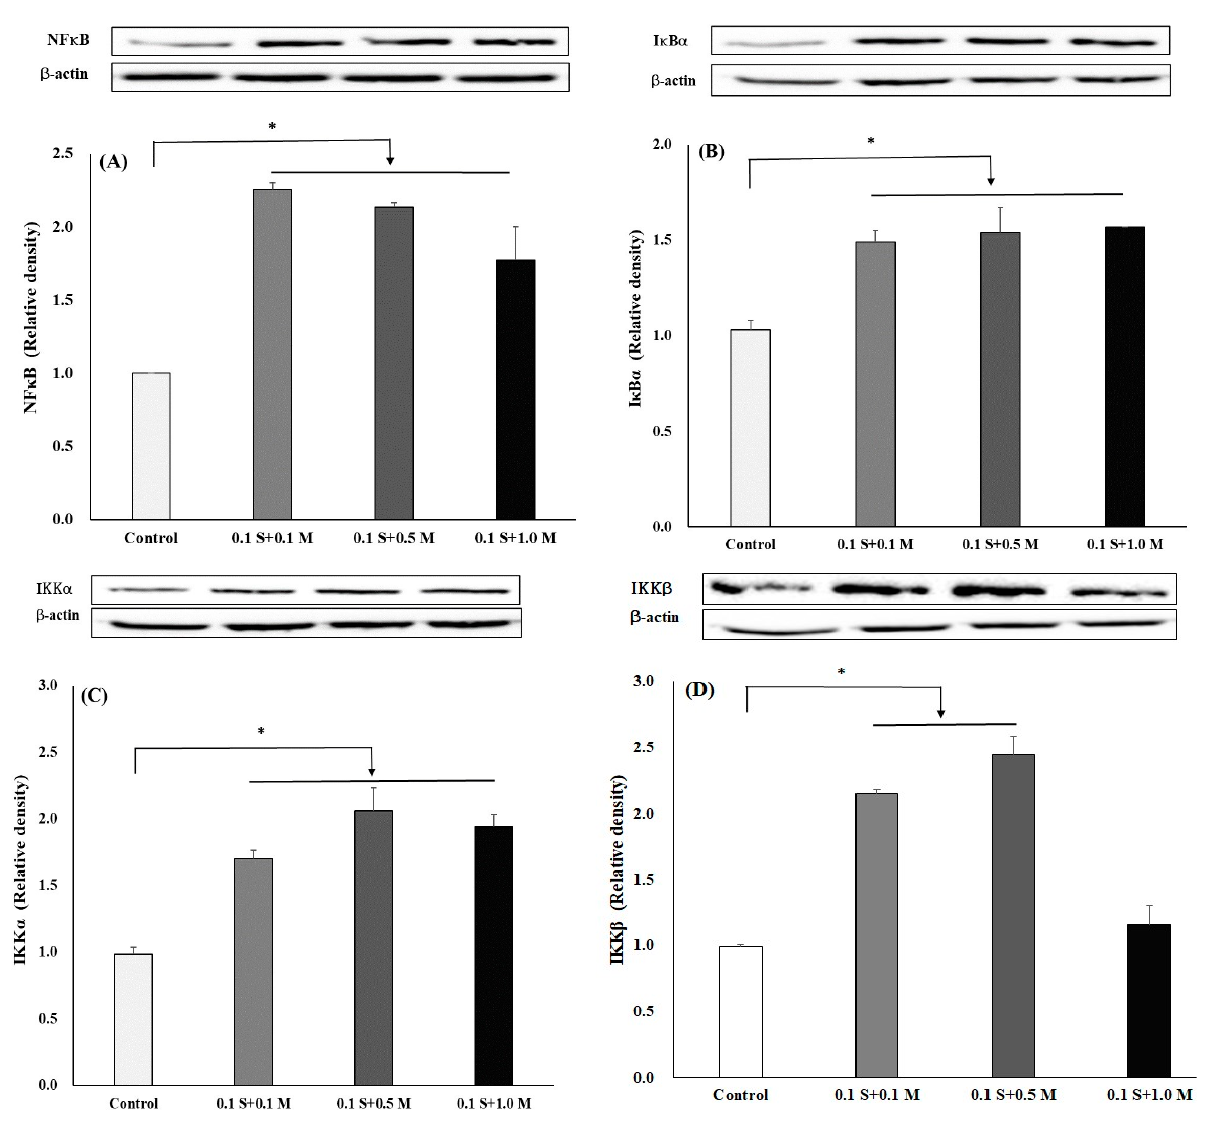
Figure 6. NF κ B pathway expression based on the ratio of the sericin and MSM blends using L929 fibroblast. Cells were treated with 1.0 (0.1S + 0.1M), 5.0 (0.1S + 0.5M), and 10.0 (0.1S + 1.0M) mg/mL MSM at 1.0 mg/mL sericin. ( A ) NF κ B, ( B ) I κ B α , ( C ) IKK α and ( D ) IKK β . L929 lysates were Western blotted with an anti NF κ B or I κ B α or IKK α or IKK β or β -actin antibody. All values are presented as the mean ± standard deviation (n = 3). * p < 0.05.